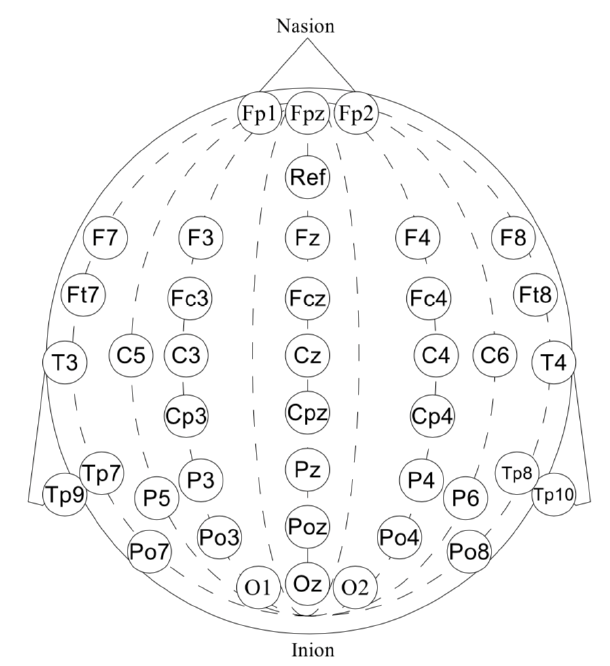
Figure 2. The 40-channel EEG: ‘Fp1’, ‘Fpz’, ‘Fp2’, ‘F7’, ‘F3’, ‘Fz’, ‘F4’, ‘F8’, ‘Ft7’, ‘Fc3’, ‘Fcz’, ‘Fc4’, ‘Ft8’, ‘T3’, ‘C3’, ‘Cz’, ‘C4’, ‘T4’, ‘Tp7’, ‘Cp3’, ‘Cpz’, ‘Cp4’, ‘Tp8’, ‘C5’, ‘Tp9’, ‘P3’, ‘Pz’, ‘P4’, ‘Tp10’, ‘C6’, ‘P5’,